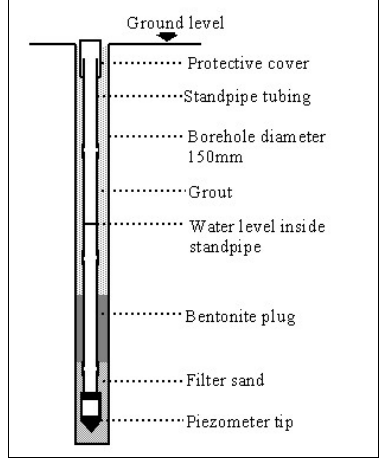
Figure 2. Scheme of borehole and piezometer